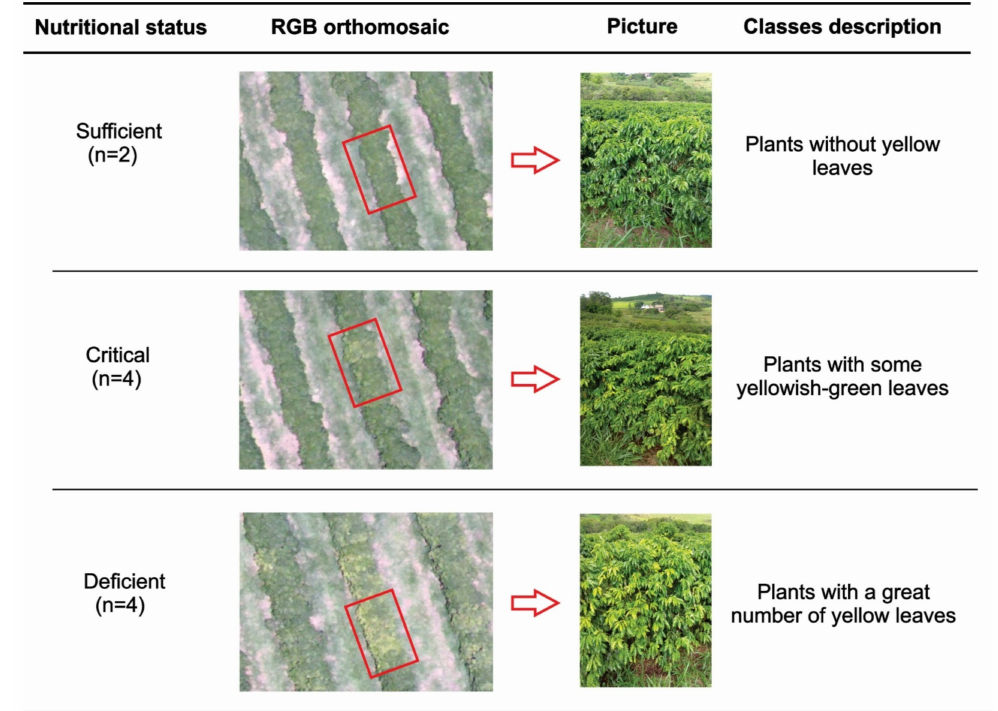
Figure 3. Description of the classes of nitrogen level in the coffee leaves identified through RGB (red, green, and blue) composition in the orthomosaic images, to select sampling points in each